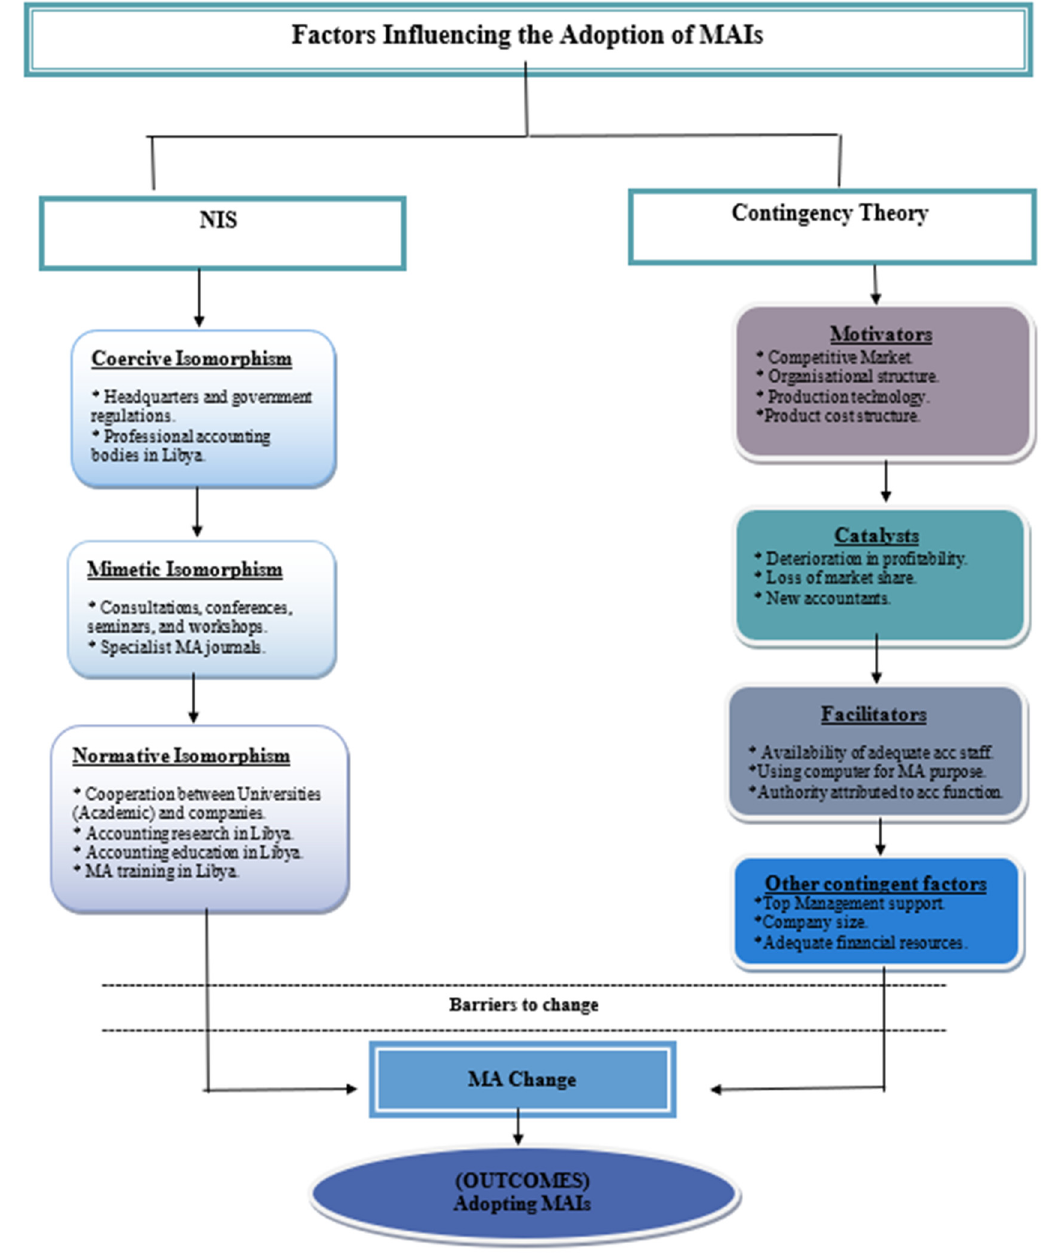
Figure 1. The study’s theoretical framework.